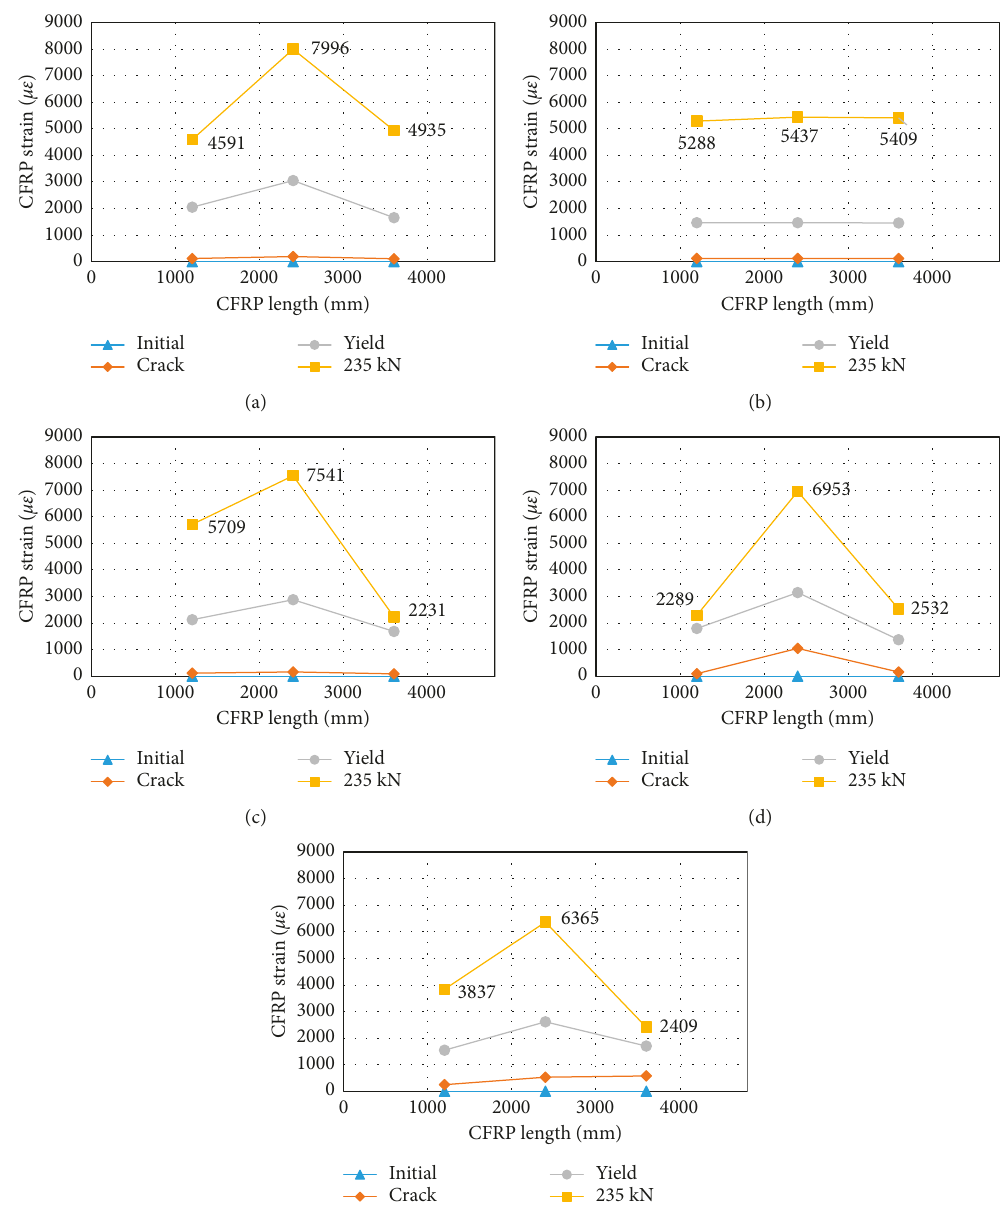
Figure 21: Strain distribution of CFRPtendon. (a) E-OX-1-B-40-0. (b) E-OX-1-UB-40-0. (c) E-OX-1-B-30-0. (d) E-OX-1-B-40-30. (e) E-OX-1-B-